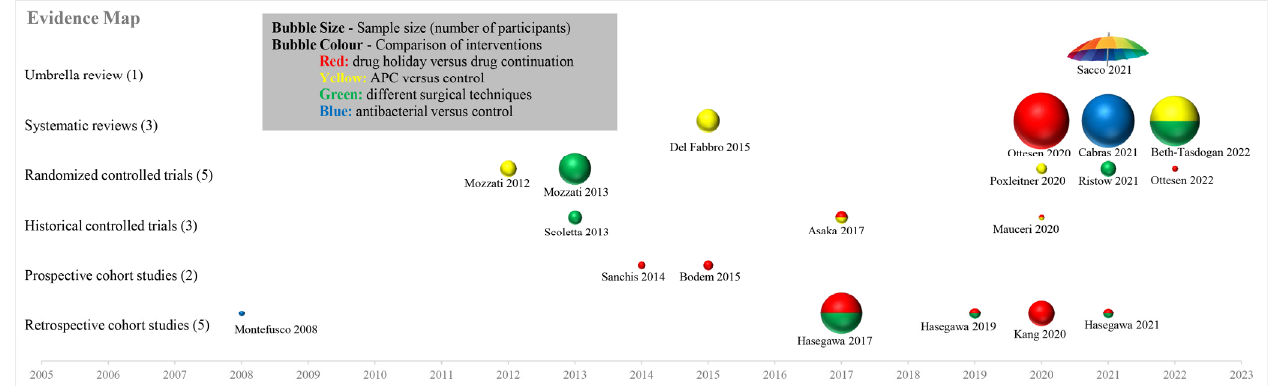
Figure 2. Evidence map (temporal profile) [15,16,24–40].